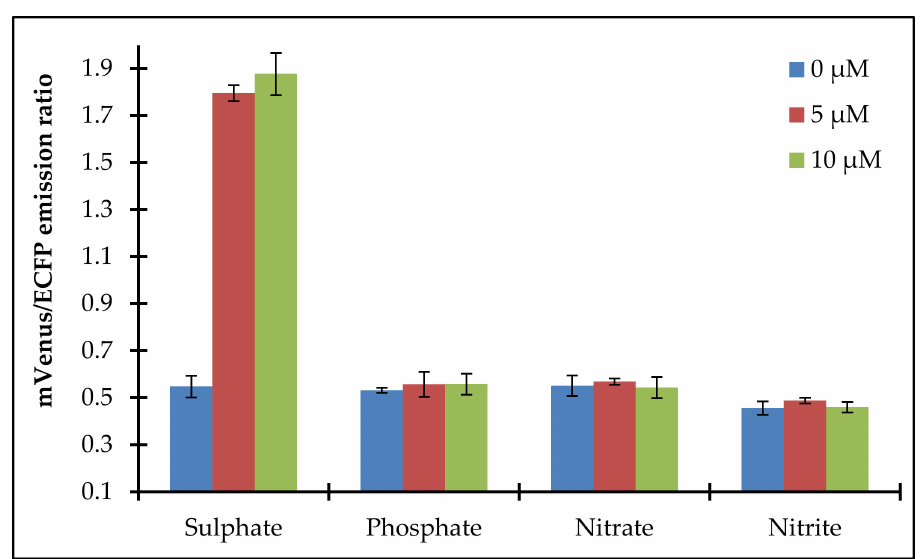
Figure 5. Specificity of the FLIP-SP sensor with di ff erent molecules. Error bars show the standard deviation of the three independent